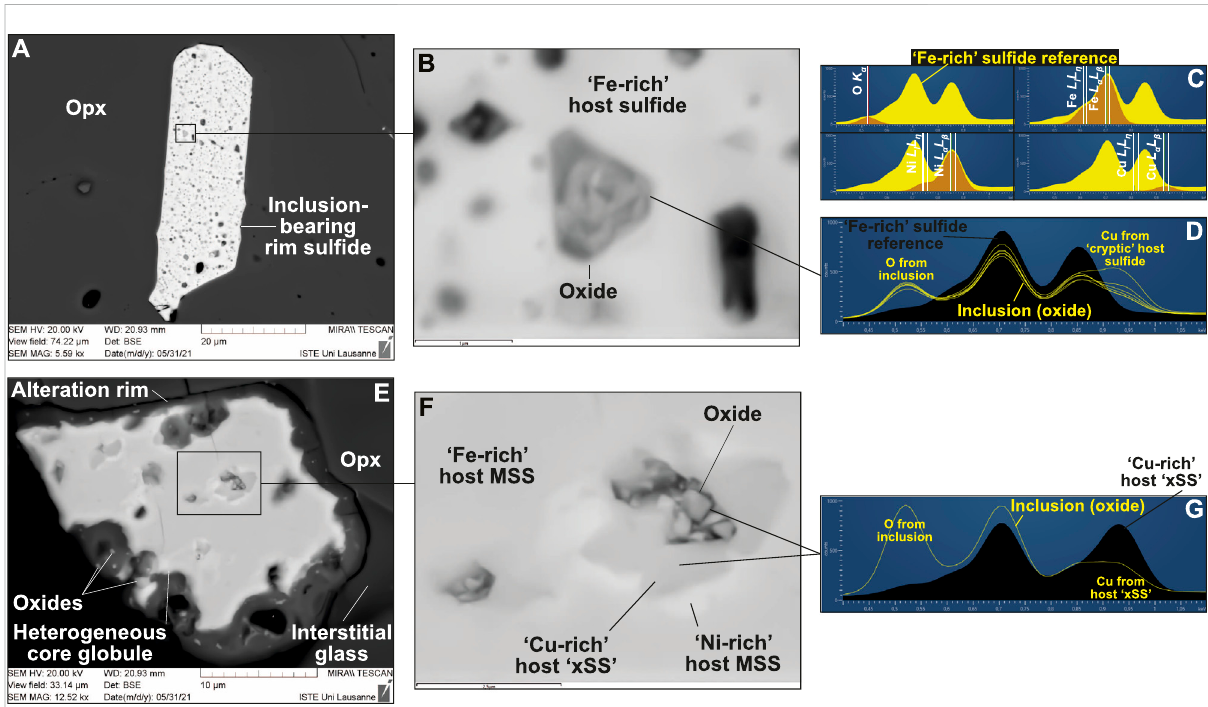
FIGURE 5 Oxide inclusions in sul fi des from the glass-bearing, Type 1A vein from West Bismarck (SEM). BSE images of (A,B) a rim sul fi de and (E,F) a core sul fi de. The EDS spectra for those oxides and their host sul fi des are respectively shown in (D) and (G) , with peak identi fi cation in (C) . Note that oxide inclusions are associated with “ Cu-rich ” sul fi de ( “ xSS ” ), either identi fi ed using EDS spectra only in (D) ( “ cryptic ” ) or also clearly visible in BSE images in (E,F) . Non-included oxides are localized at sul fi de rims in (E)